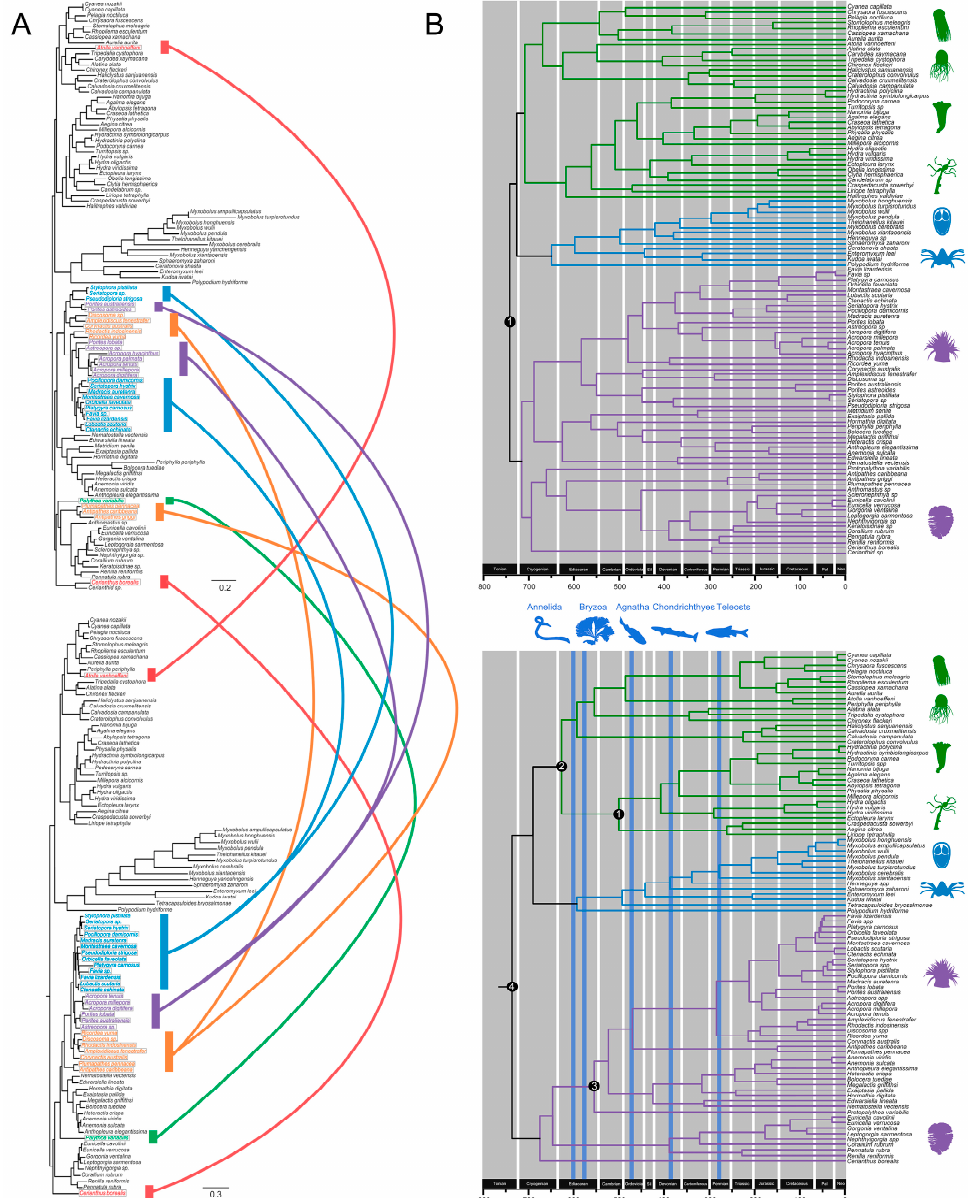
Figure 6. ( A ) Congruence between the nematocyst core protein tree (upper panel) and organismal tree (lower panel). Nematocyst protein tree based on the concatenated protein alignment of five nematocyst core proteins. Species tree based on the concatenated protein alignment of 146 single-copy proteins. Cnidarian groups are shaded to highlight incongruencies resulting from gene transfer events. ( B ) Chronogram of nematocyst (upper panel) and cnidaria (lower panel) evolution inferred using r8s. We used the phylogeny resulting from concatenations of five and 146 genes in our age estimation. Calibration points for nematocyst chronogram were as follows: (1) Cnidaria max-age (~741 Mya) is marked with solid circles. Calibration points for the Cnidaria chronogram: (1) origin of Hydrozoa (500 Mya), (2) Medusozoa minimum age (~570 Mya), (3) Hexacorallia min age (~540 Mya), and (4) Cnidaria max-age (~741 Mya) are marked with four solid circles. Neo = Neogene, Pal = Paleogene, Sil = Silurian.